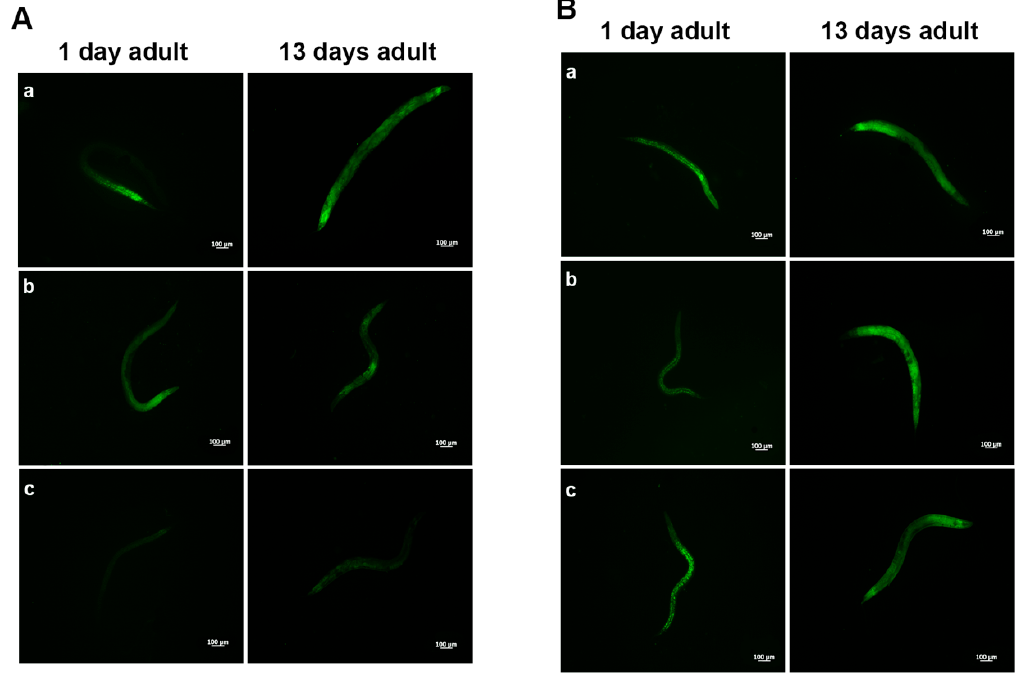
Figure 3. Visualization of lipid droplets. ( A ) BODIPY staining of one and 13 days adult worms grown in the presence of OP50 ( a ), LGG ( b ) or L. fermentum MBC2 ( c ) as food sources. ( B ) BODIPY staining of heat-killed bacteria-fed worms. Nematodes were grown on OP50 ( a ), LGG ( b ) or L. fermentum MBC2 ( c ). Scale bar = 100 μ m.